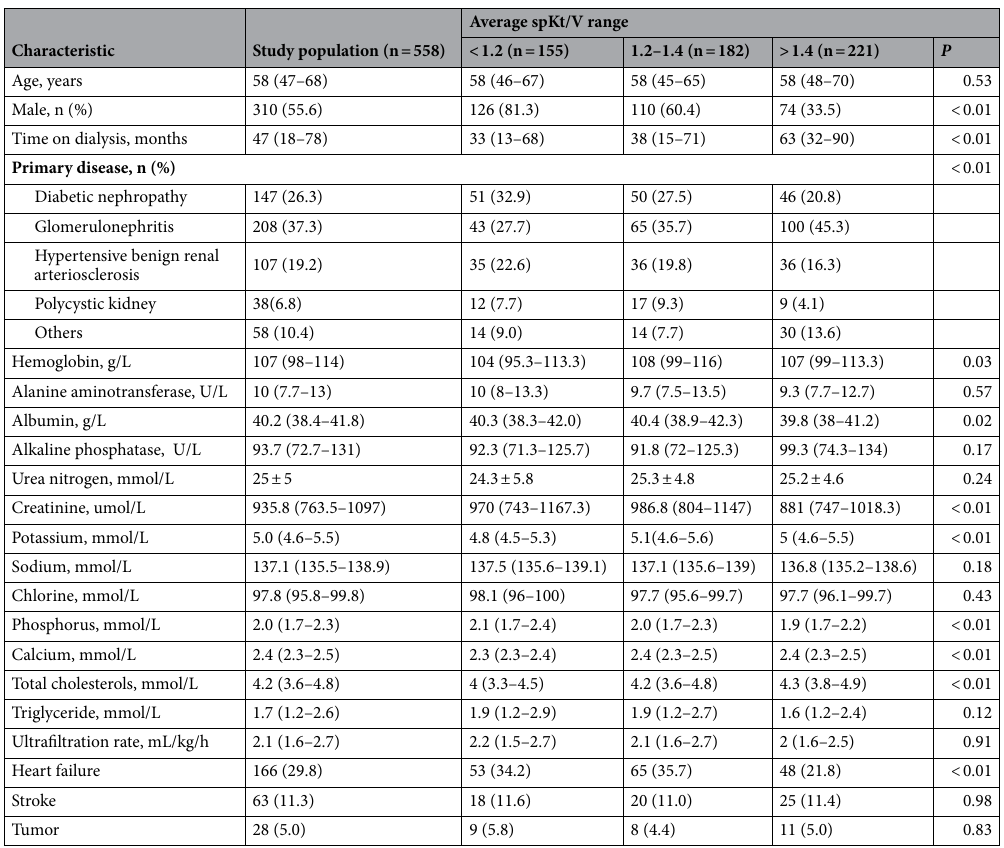
Table 1. Baseline characteristics of the study patients. Data are displayed as mean ± standard deviation or median [quartile1 − quartile3] for continuous variables and number (percent) for categorical variables. P values were determined with one-way ANOVA or Kruskal–Wallis H tests for continuous variables and chi- square test for categorical variables. All statistical tests are two